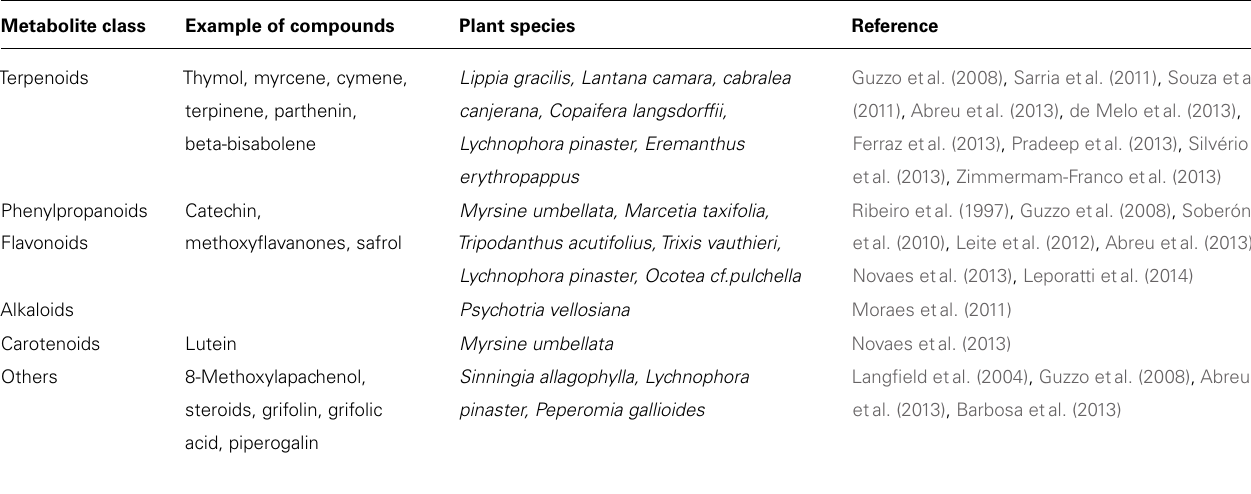
Table 2 | Examples of secondary metabolites found in plant species from Minas Gerais (MG) and identified in canga outcrop by Jacobi etal. (2007). Metabolite